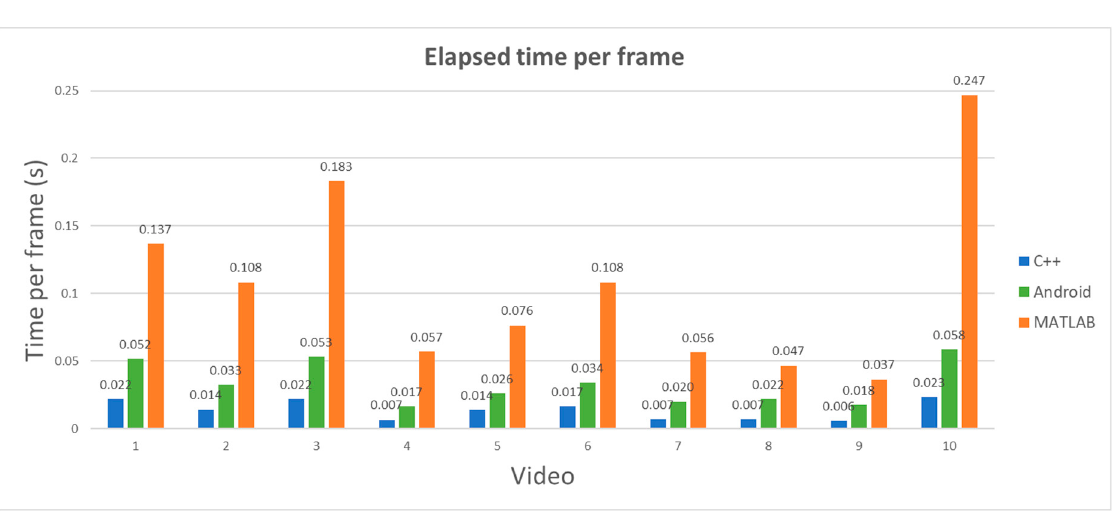
Figure 10. Histogram showing a comparison of the three di ff erent implementations. Each test was repeated 3 times.